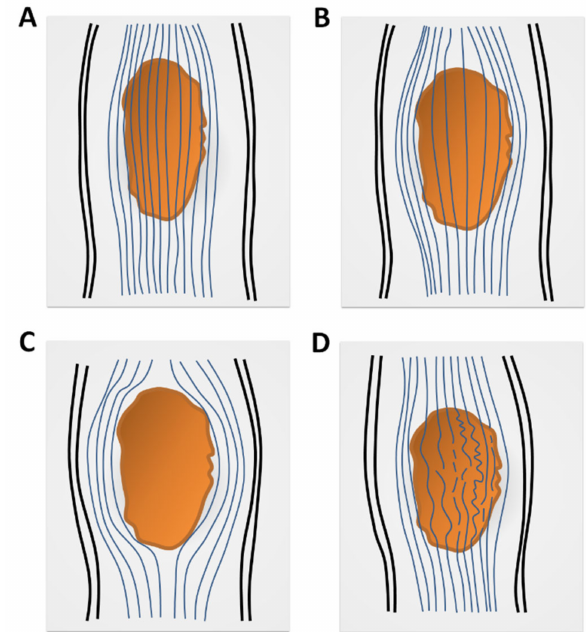
Figure 4. Schematic images of di ff usion-tensor-tractography (DTT) features in spinal-cord lesions (the orange areas in the images). ( A ) Intact white-matter tract; ( B ) spread of white-matter tracts with fibers entering lesion; ( C ) displaced white-matter tracts without fibers entering lesion; ( D ) interrupted white-matter tracts. Illustrations derived and modified from Liu X et al.